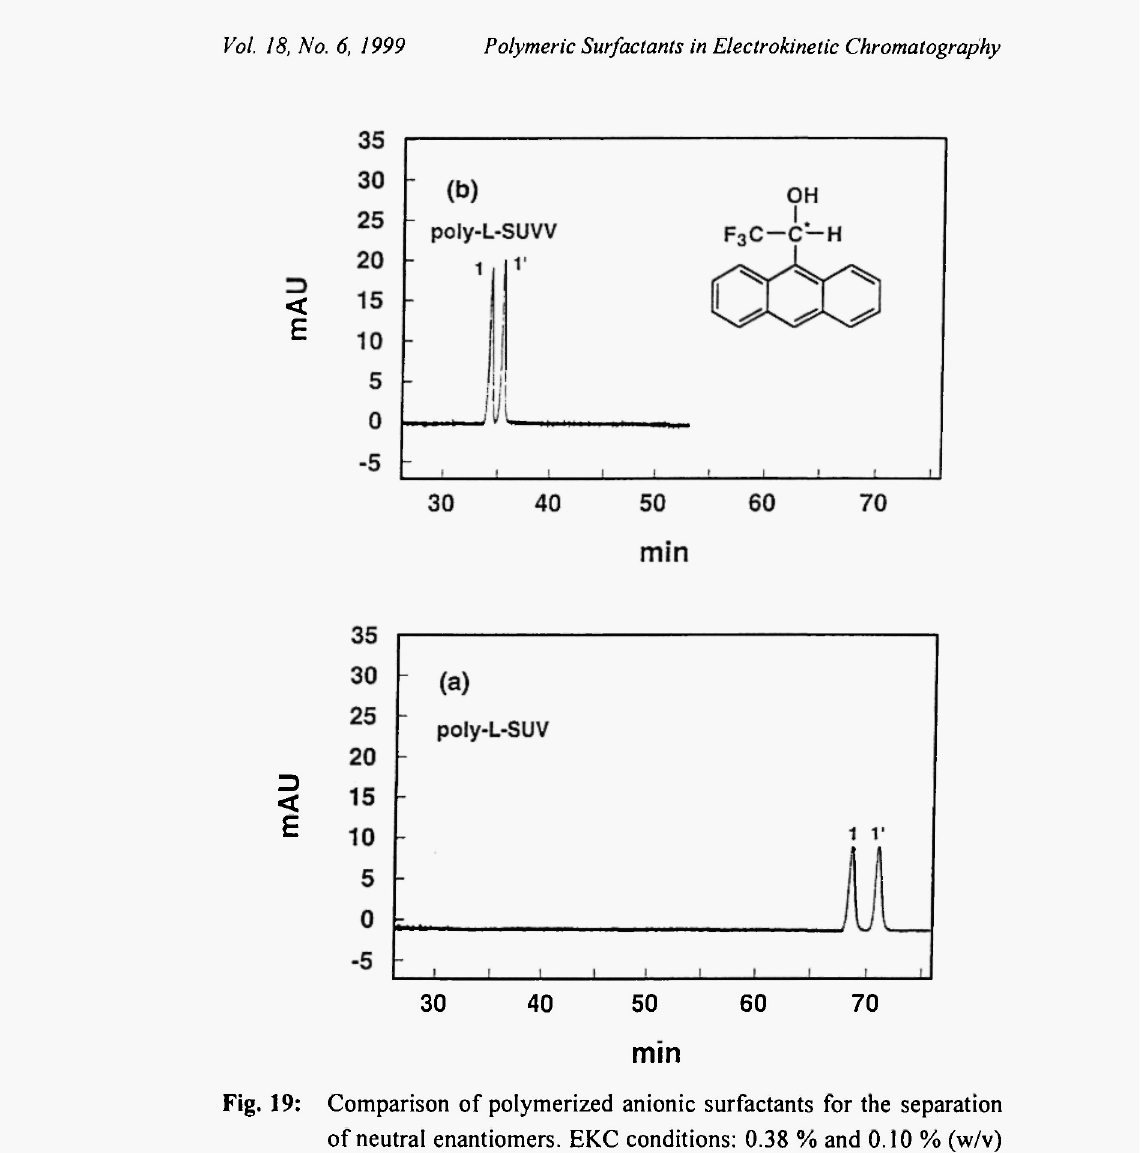
Fig. 19: Comparison of polymerized anionic surfactants for the separation of neutral enantiomers. EKC conditions: 0.38 % and 0.10 % (w/v) of poly-L-SUV and poly-L-SUVV in 50 mΜ Na 2 B 4 0 7 buffered at pH 10.2. Peak identification: 0.1 mg/mL each of (1) (-)-TFAE, (Γ) (+)-TFAE. Pressure injection for 4 s; +20 kV applied for separation, current 82 μΑ for poly-L-SUV and 78 μΑ for poly-L-SUVV. UV detection was at 254 nm. From /58/ with